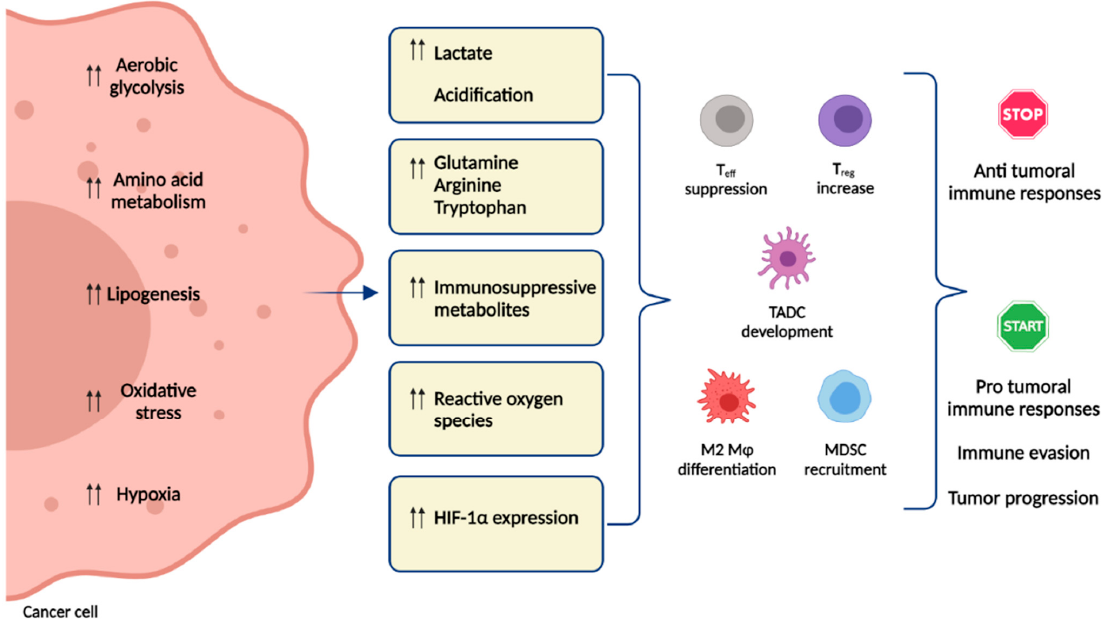
Figure 1. Implications of tumor metabolic reprogramming on immune responses. The immune response is affected by metabolic reprogramming in the TME and is driven by the increased demand for energy sources (glucose) and nutrients (glutamine, arginine, tryptophan) by cancer cells. Tumor-derived metabolites, such as lactate, prostaglandins, kynurenines, fatty acids, adenosine or reactive oxygen species, inhibit T eff cell proliferation and cytotoxicity, turning off anti tumoral immune responses. Several immunosuppressive cells are activated or recruited to the TME (e.g., T reg , M2 M φ , MDSC, TADC), favoring tumor progression. Double arrows indicate the upregulation of metabolic pathways in tumor cells. Abbreviations: T eff , effector T cells; T reg , regulatory T cells; M2 M φ , activated M2 macrophages; MDSC, myeloid-derived suppressor cells; TADC, tumor-associated dendritic cells.